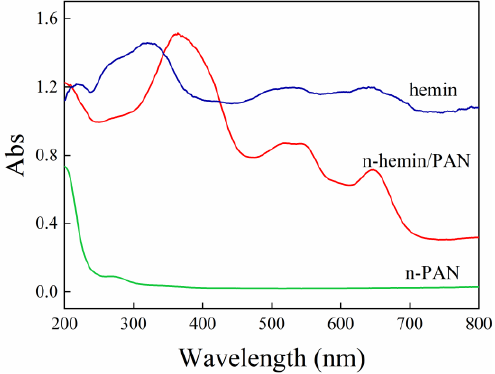
Figure 7. DRS spectra of n-PAN, hemin, n-hemin/PAN.